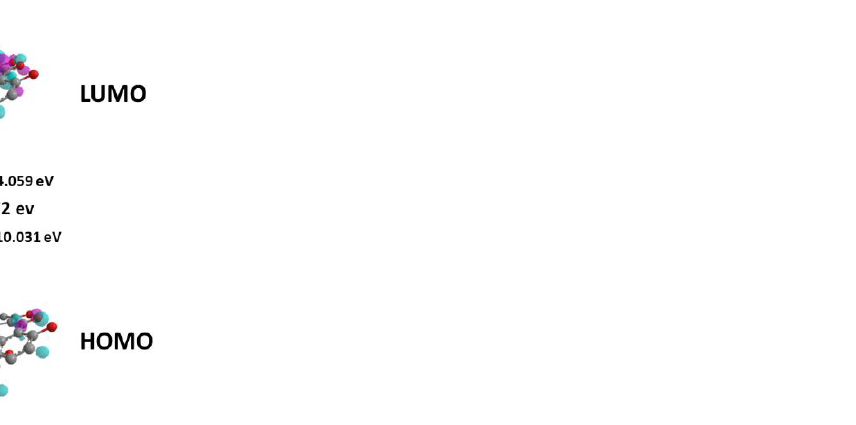
Figure 5. Surfaces of HOMO, LUMO and gap value to phomoxanthone A. In purple, the positive contributions and in cyan blue the negative contributions to the orbitals.